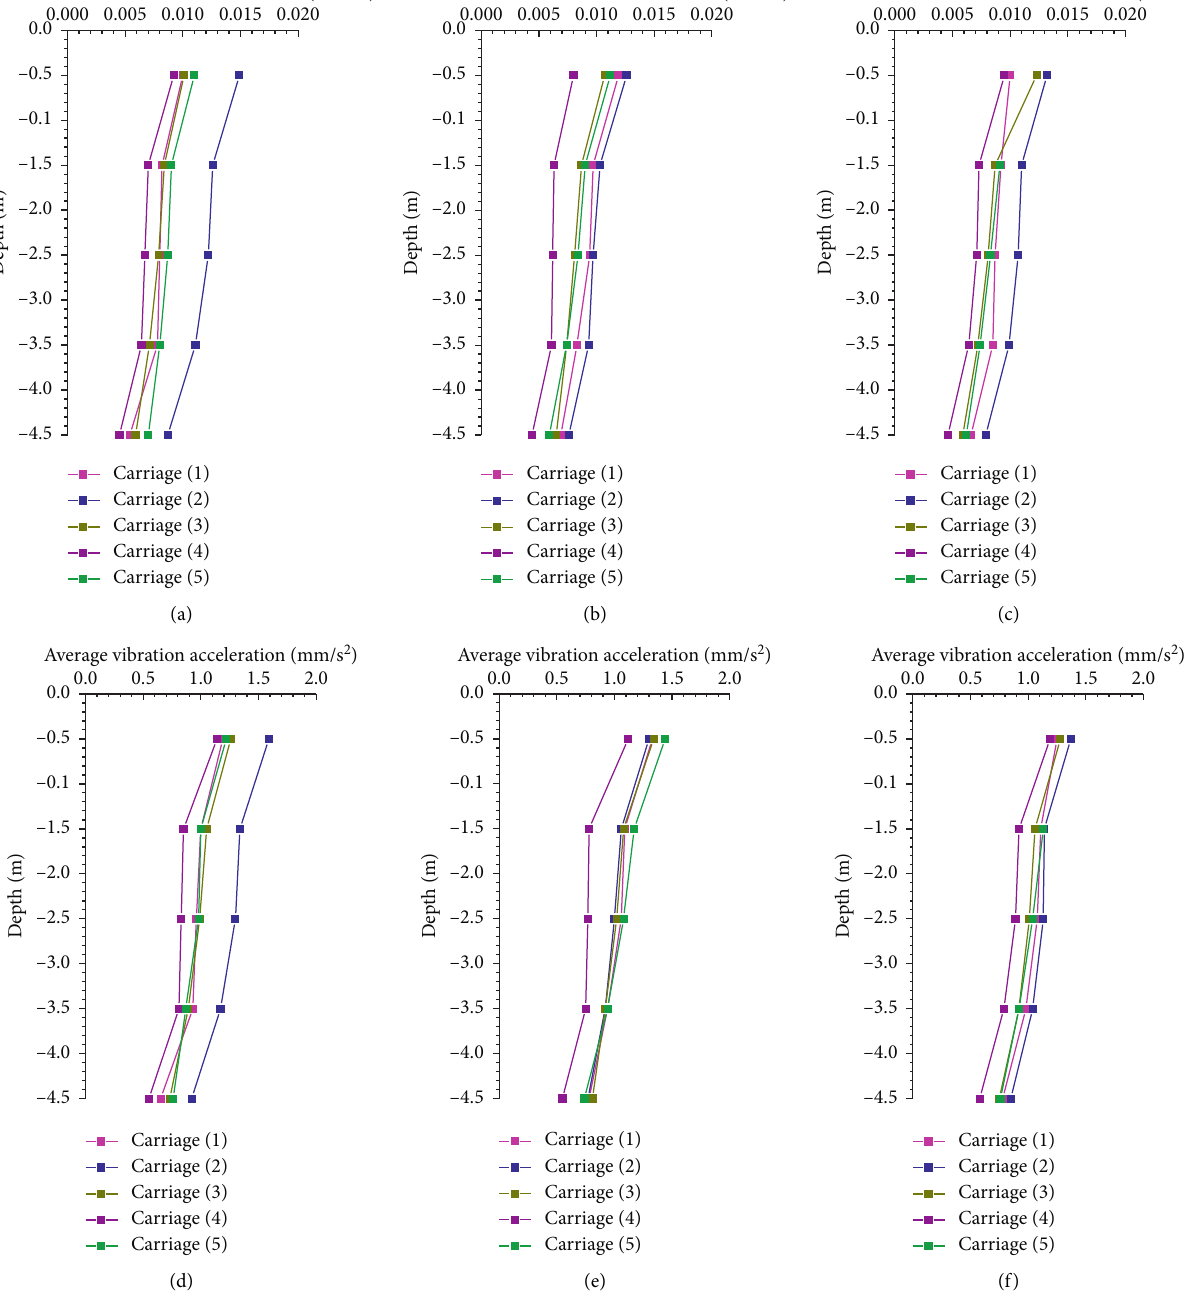
Figure 11: Effective value and average value of vertical vibration acceleration at K331+315 measuring point. (a) Effective value attenuation curve in September 24th. (b) Effective value attenuation curve in October 10th. (c) Effective value attenuation curve in October 24th. (d) Average attenuation curve in September 24th. (e) Average attenuation curve in October 10th. (f) Average attenuation curve in October